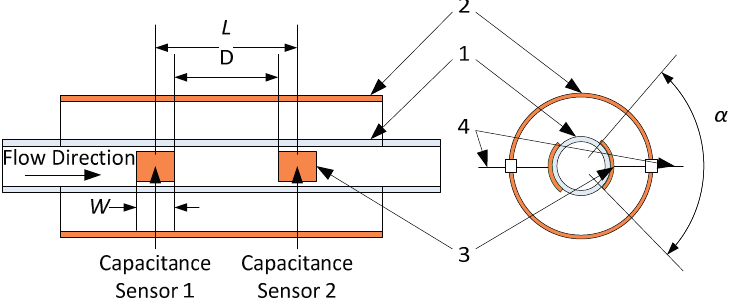
Figure 1. Structure of the capacitance sensor ( 1 . Glass micro-pipe; 2 . Copper